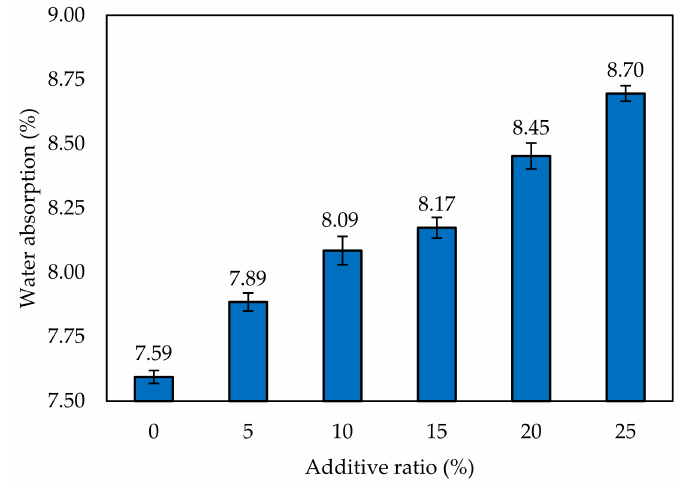
Figure 5. The water absorption test results of cementitious composites.